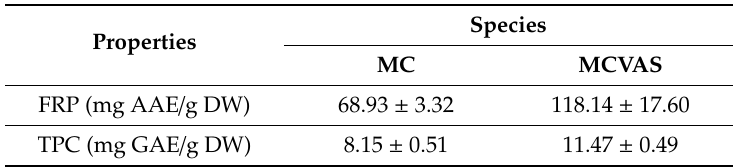
Figure 4. Effects of sample concentration on ( a ) ferric reducing power and ( b ) total phenolic content. Table 2. Ferric reducing power and total phenolic content values of Momordica charantia L. and Momordica charantia L. var. abbreviata Ser. in this study.